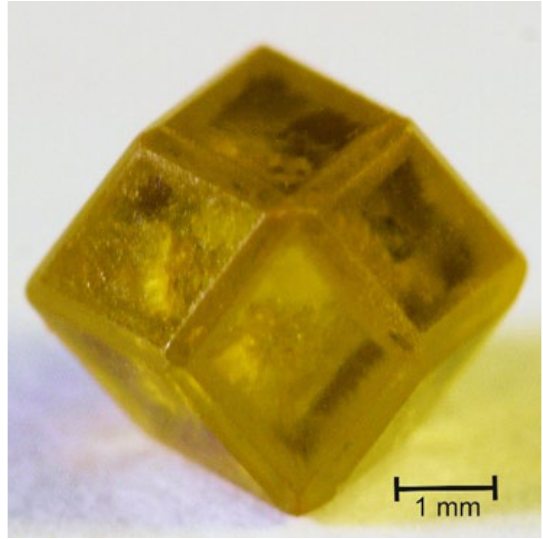
Figure 6. The demantoid crystal from the Ufaleiskiy manifestation. The study of “horsetail” inclusions in transparent, thin sections of the demantoid under a microscope, with and without an analyzer, did not reveal the presence of any mineral phases. When rotating the microscope table, only the reflection from the surface of the inclusions were observed. Sometimes, the chips made through the central part of the demantoid grain clearly showed its sectoral-radial structure (Figure 8a,b): the individuals of the demantoid diverged from the center along radians expanding rapidly. In some places, induction surfaces with coarse transverse striations were clearly visible. There were also longitudinal thin grooves, the number and size of which increased rapidly toward the periphery of the grain (see Figure 8b). These are the “horsetail”